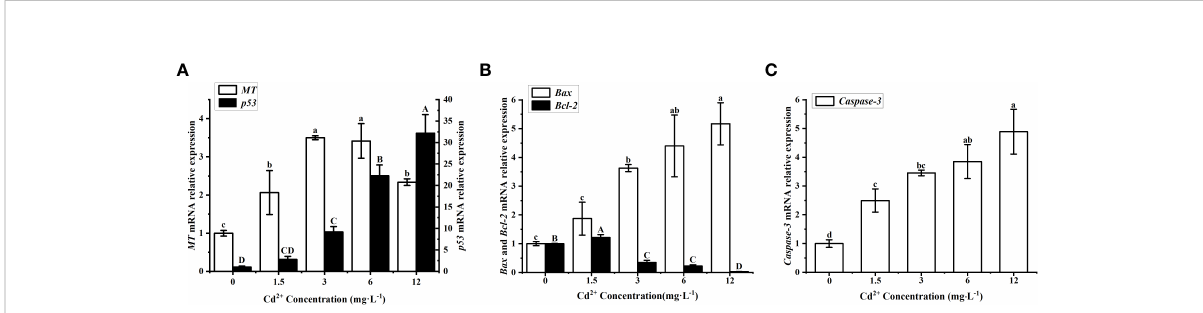
FIGURE 6 Effects of Cd on apoptotic markers in M. meretrix ovary. (A) p53 (white bars) and MT mRNA (black bars); (B) Bax (white bars) and Bcl-2 mRNA (black bars); (C) Caspase-3 mRNA. Different letters indicate signi fi cant ( P < 0.05) differences among groups as revealed by Tukey ’ s post-hoc multiple comparison tests; Data are expressed as means ± SE (n = 6).